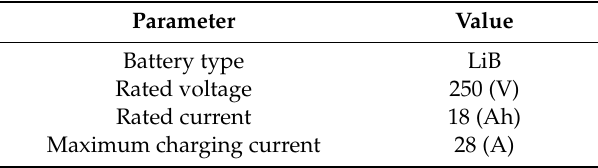
Table 2. Battery parameters.